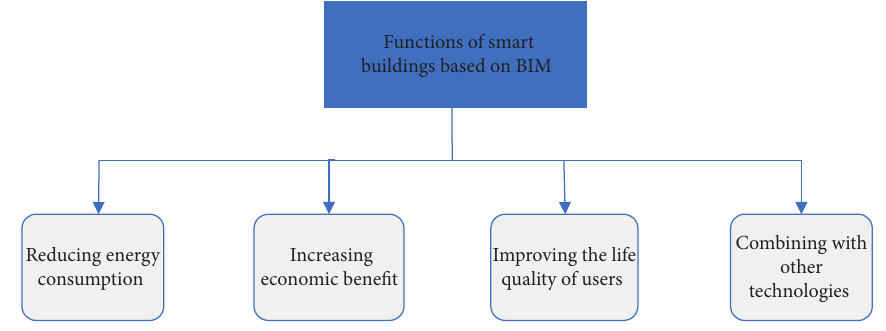
Figure 5: Smart building functions based on